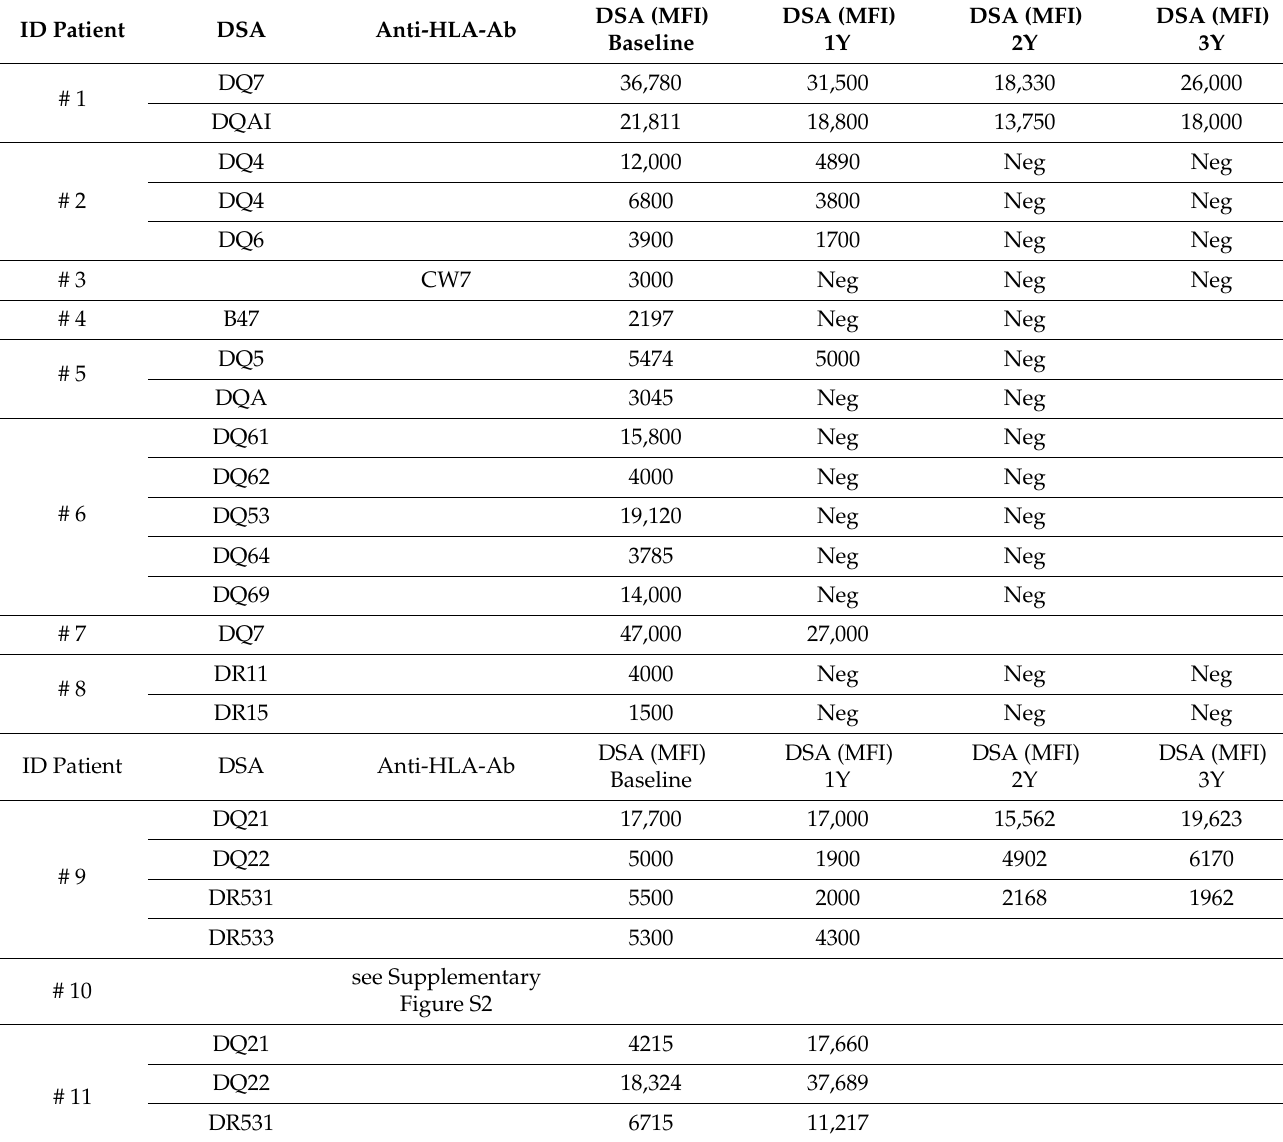
Table 2. Anti-HLA antibody (DSA and not DSA) serum levels expressed as the mean fluorescence intensity (MFI) at the baseline and after the ECP